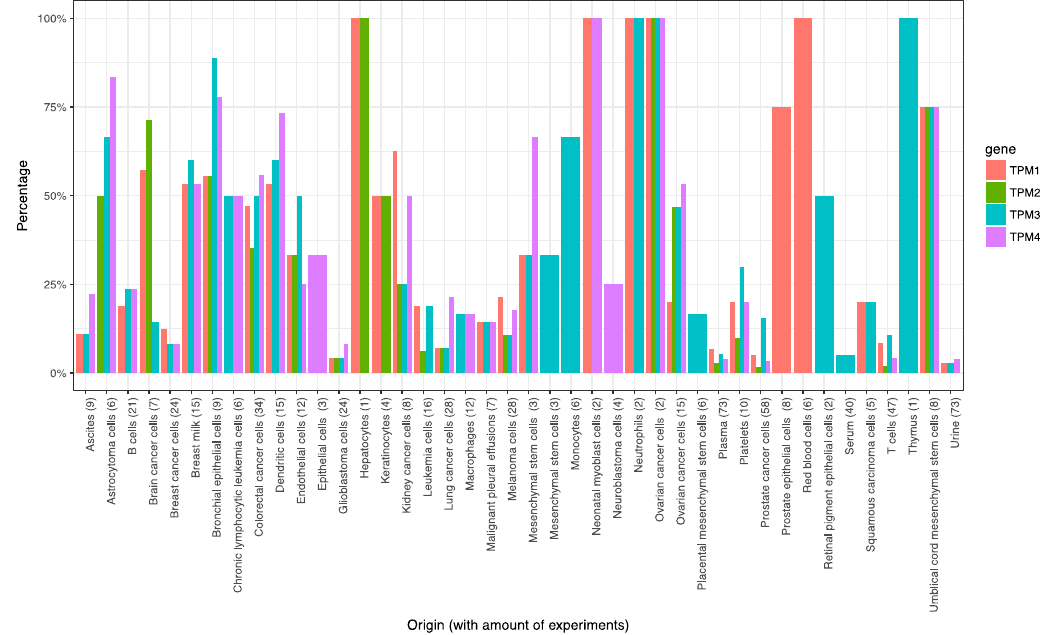
Figure 2. Frequency of TPM1 , 2 , 3 and 4 in experiments reported in Vesiclepedia. X -axis: targeted substrate/origin of the study including the amount of experiments in brackets; Y -axis: frequency in experiments (human-based data only, substrates with no TPM detected not shown).